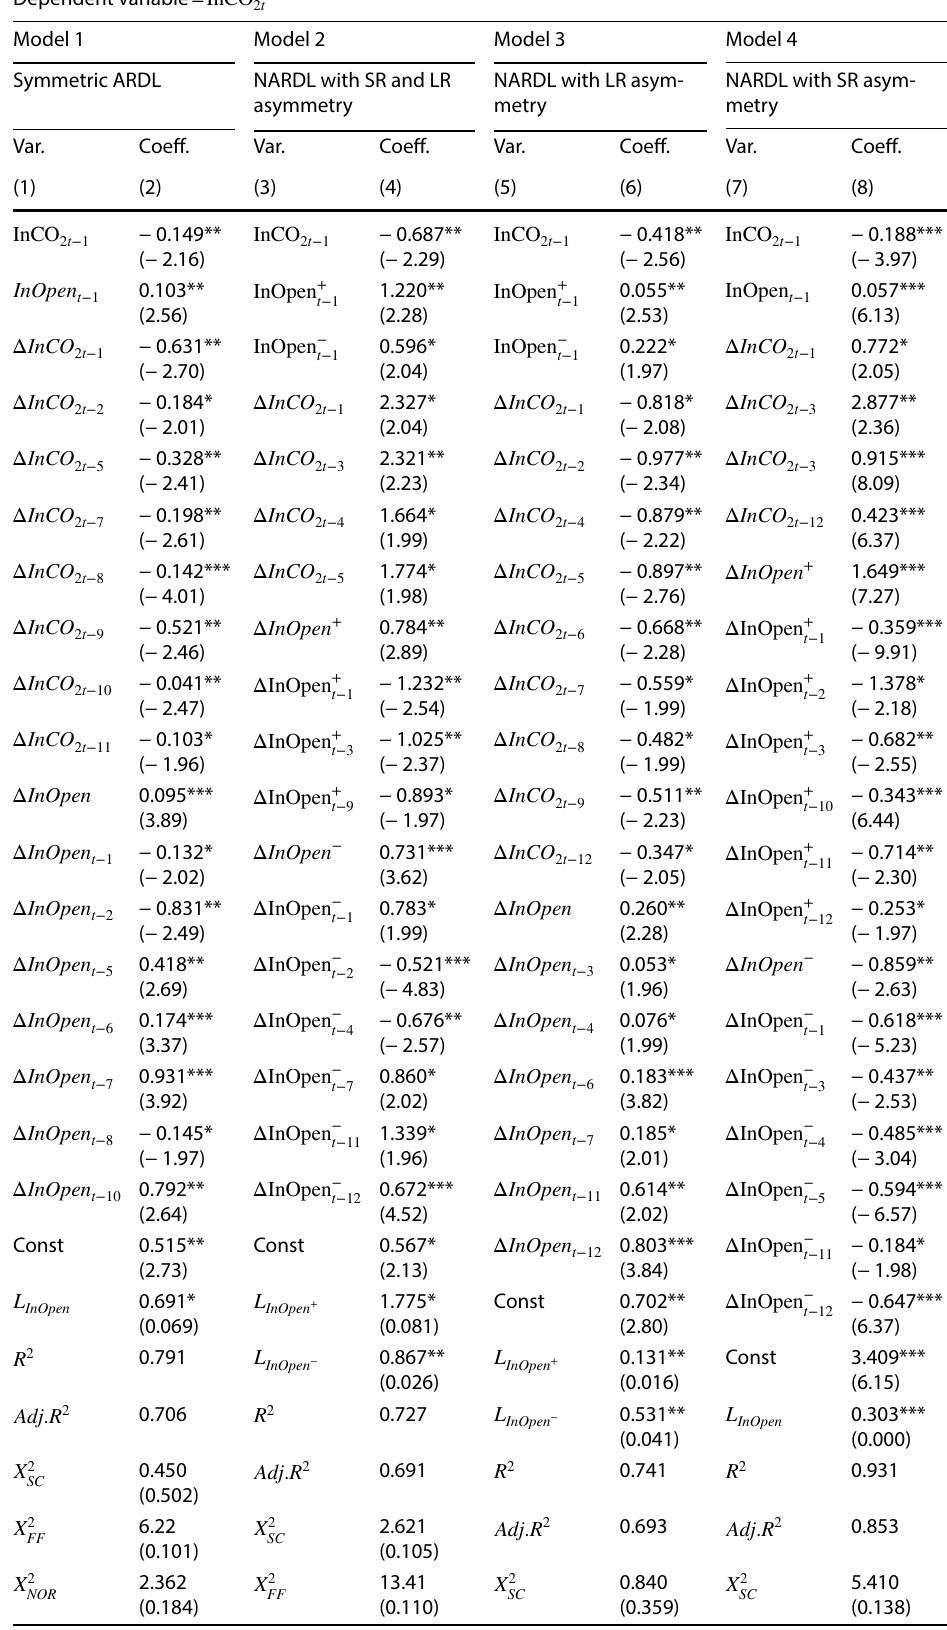
Table 10 Full-information estimates of both symmetric ARDL and nonlinear ARDL (NARDL) models in